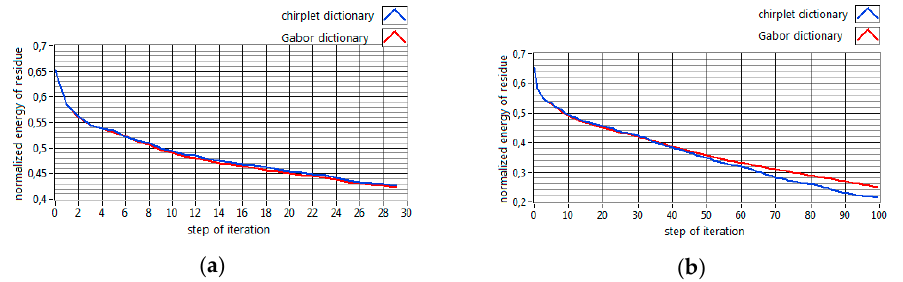
Figure 1. The normalized energy of the residue as a function of number of iterations in MP algorithm for the adaptive expansion of the measured signal representing the MFD in surroundings of the ship’s motor drive during maneuvers. The size of the dictionary is equal to: ( a ) 30 and ( b ) 100. The MP method was applied in the virtual application, designed in LabVIEW software (version 2012, National Instruments Corporation, Austin, TX, USA) [22] (Figure 2). The numerical implementation of the presented method of the joint time-frequency analysis uses the LabVIEW library. There are VIs that implement an adaptive transform and adaptive expansion based on the MP algorithm. The discrete representation of the adaptive Gaussian function is defined by [22]: